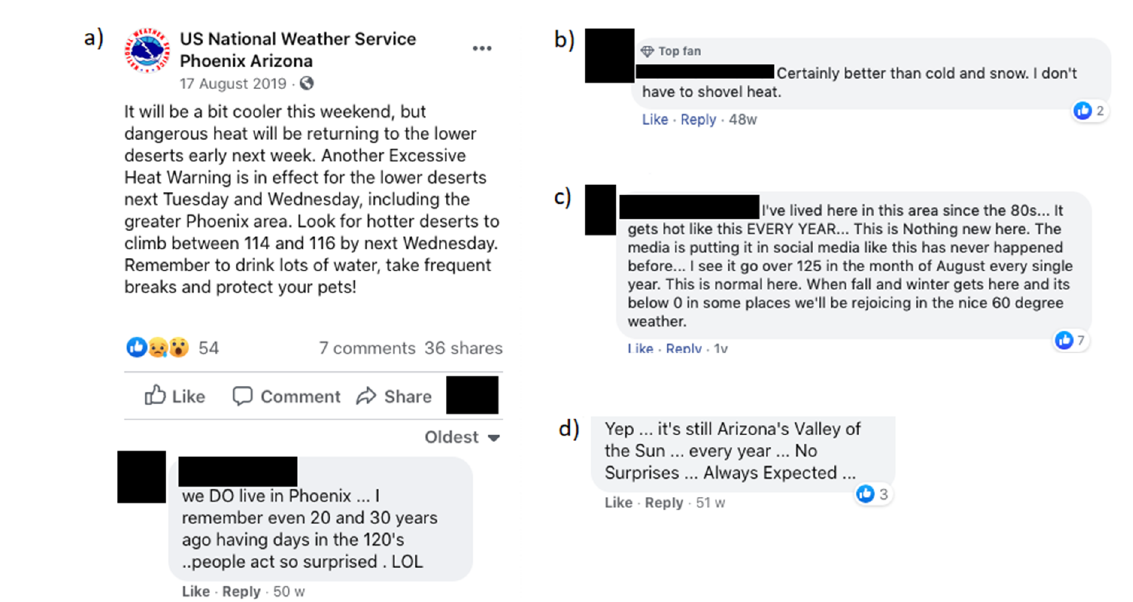
Figure 1. (a–d) Comments posted by the public in Phoenix, AZ, reflecting the normalization of (and their resignation toward)